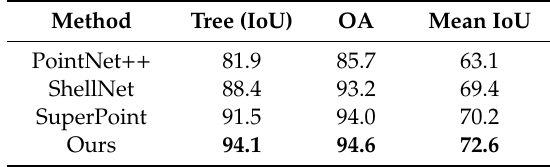
Table 6. Quantitative comparison between our model and other methods on the DALES 3D dataset. We report the overall accuracy, mean IoU and per IoU for tree category. Our model outperforms all other methods on the DALES dataset. We also note that all methods had a large variance between object categories. The boldface text indicates the best performance (All values are in %).